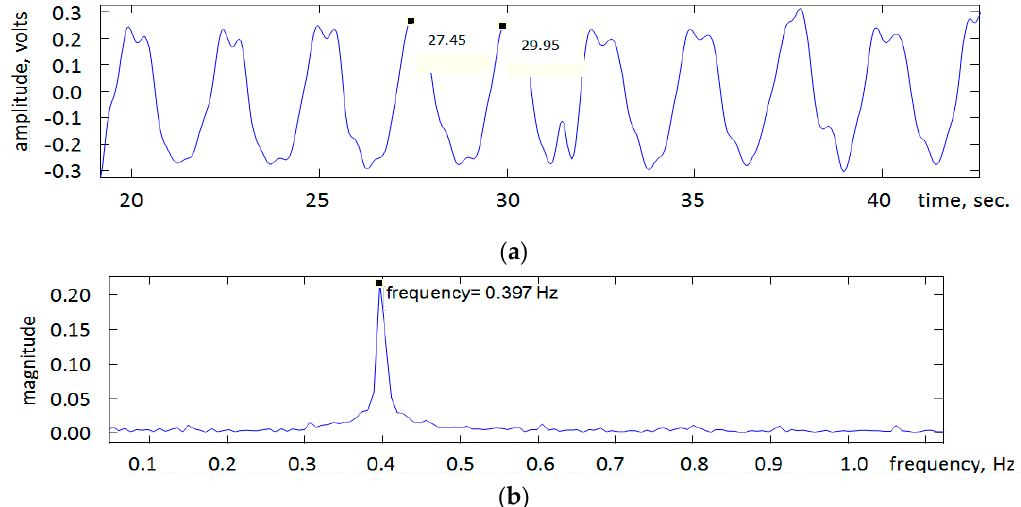
Figure 4. ( a ) An example of the recorded US signal. The values shown on the signal represent times in seconds associated with two successive peaks and thus their subtraction provides the signal's period from which frequency can be determined. ( b ) The magnitude spectrum of the US signal indicating signal frequency.